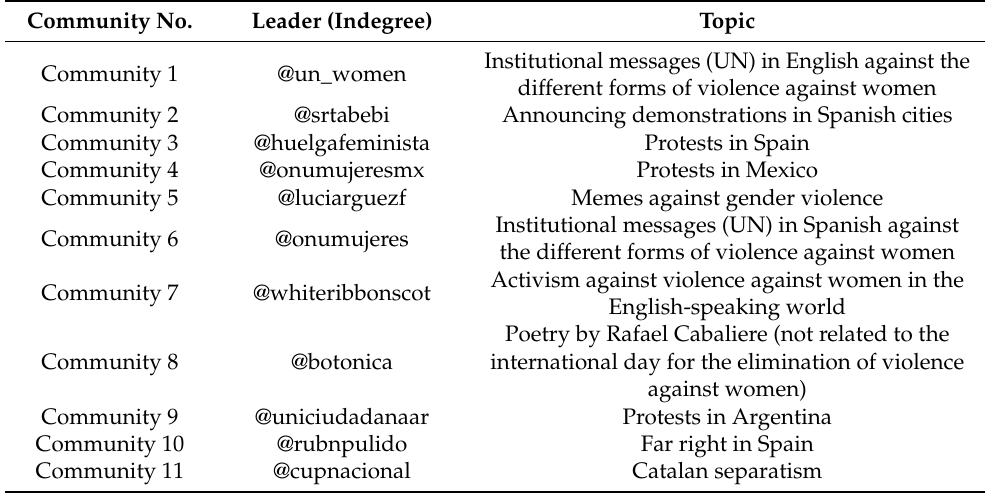
Table 1. Communities (clusters) detected according to the study’s hashtags. Community No. Leader (Indegree) Topic Institutional messages (UN) in English against the Community 1 different forms of violence against